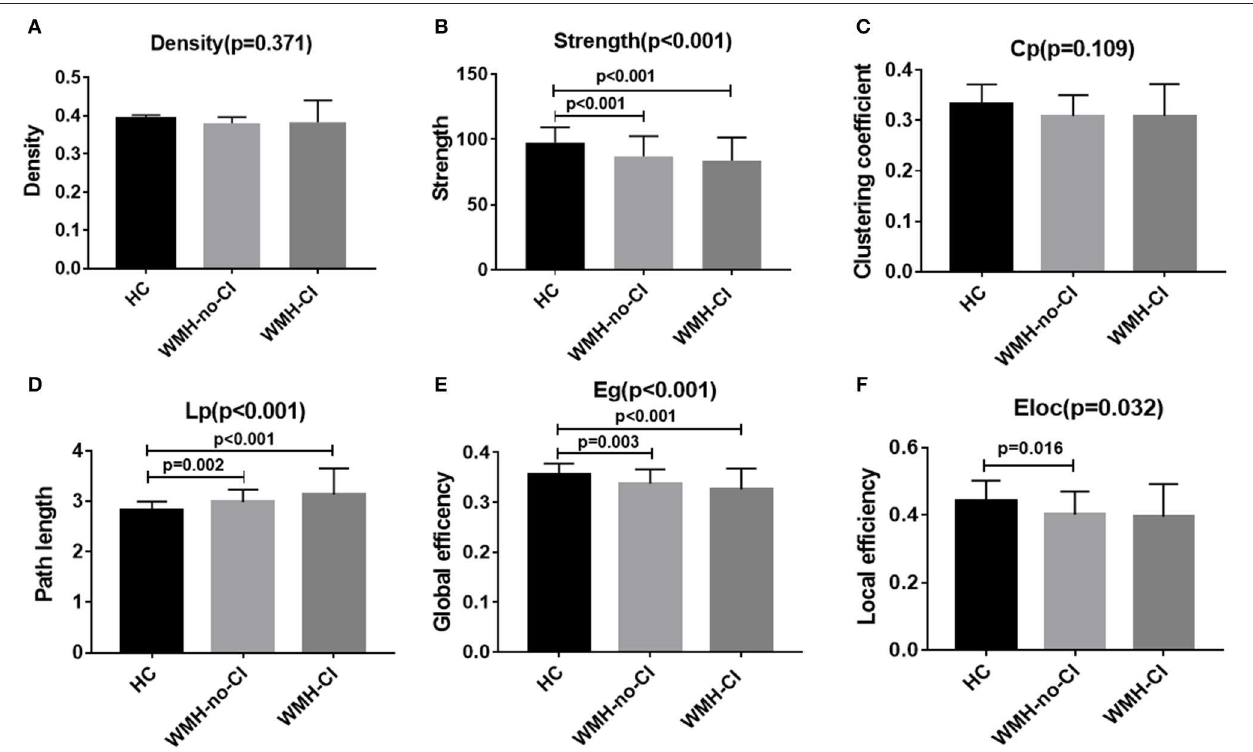
FIGURE 1 | Bar graph of group differences on the whole-brain network properties. Data were presented as mean ± SD. (A,C) No significant difference in network density and clustering coefficient among the three groups (ANCOVA, P > 0.05). (B,E) WMH-no-CI and WMH-CI groups displayed lower network strength and global efficiency than HC group (ANCOVA, P < 0.001; Bonferroni-corrected, P < 0.05/3). (D) WMH-no-CI and WMH-CI groups displayed higher path length than HC group (ANCOVA, P < 0.001; Bonferroni-corrected, P < 0.05/3). (F) WMH-no-CI group displayed lower local efficiency than HC group (ANCOVA, P < 0.05; Bonferroni-corrected, P < 0.05/3). Cp, clustering coefficient; CI, cognitive impairment; Eg, global efficiency; Eloc, local efficiency; HC, healthy controls; Lp, path length; WMH, white matter